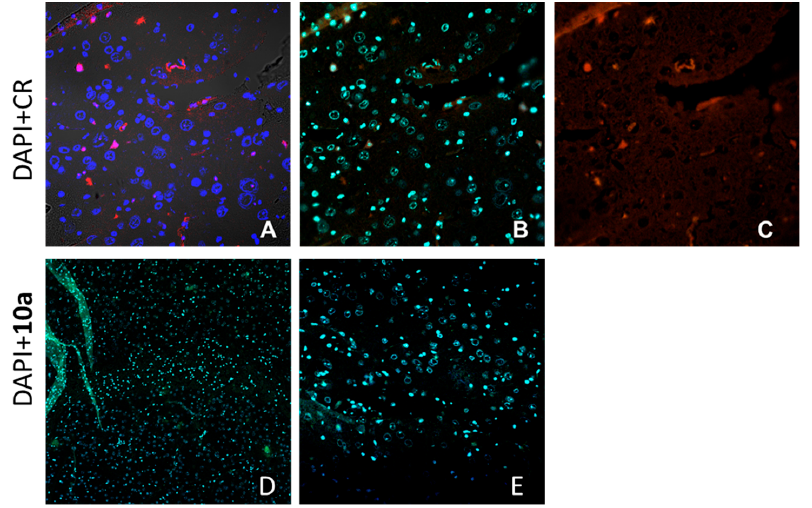
Figure 9. Staining of brain samples of 5xFAD line mice with commonly used dyes. ( A )-channel mode image, ( B ) blue channel DAPI nuclear dye: excitation 405, fluorescence registration 410–440, ( C ) red channel Congo red (CR): excitation 561, registration 570–600 (top). As well as staining of the brain of 5xFAD mice line with the test substance 10a. ( D )–staining with DAPI and experimental dye 10a dissolved in DMSO; ( E )–staining with DAPI and experimental dye dissolved in ethanol. Eu(III) complex 10a . Under all excitation wavelengths, only DAPI fluorescence was visible